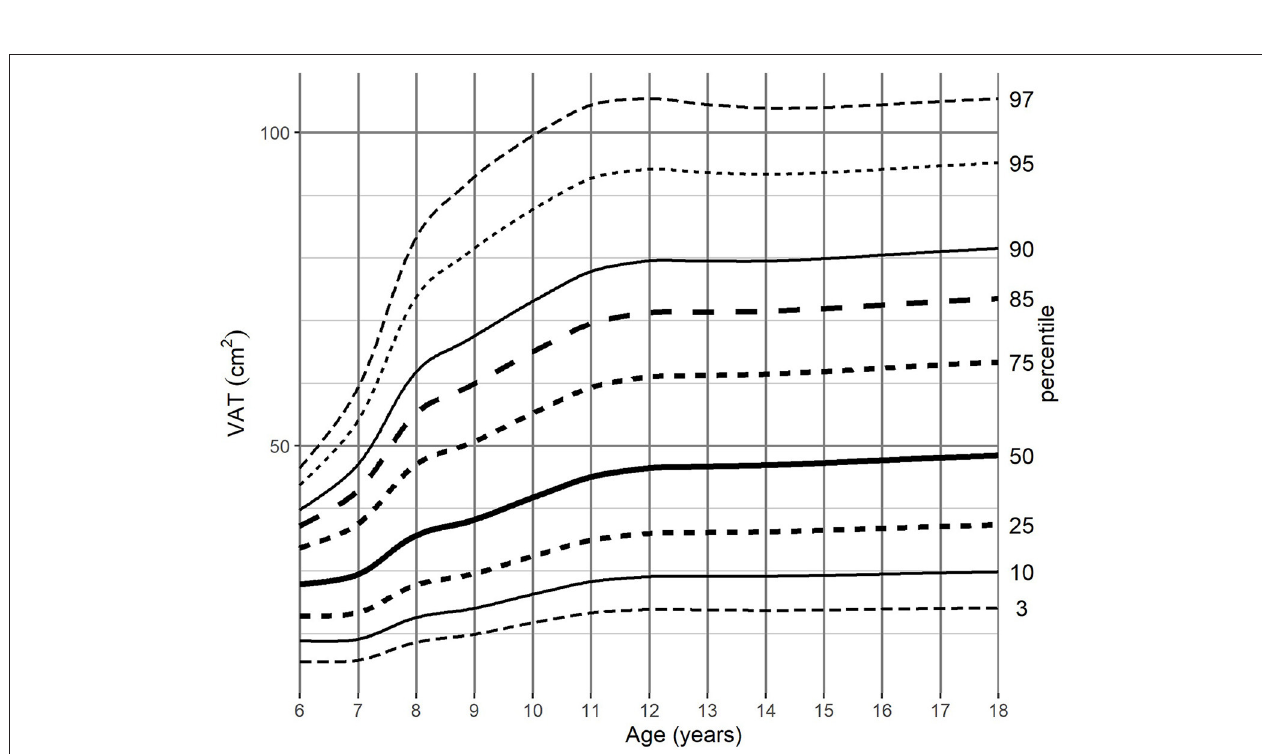
FIGURE 5 | VAT-for-age (cm 2 ) percentile charts for girls aged from 6 to 18 years. VAT, visceral adipose tissue.